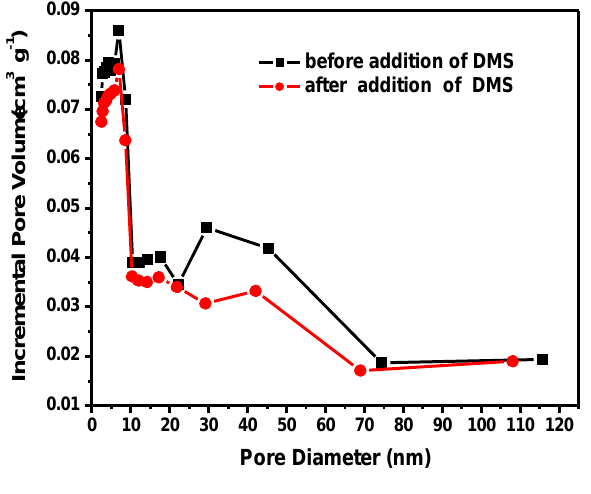
Figure 11. Pore volume distribution of a CPE with an apparent area of 4 cm 2 before (black line) and after (red line) addition of 2.5 mg cm –2 DMS [40].